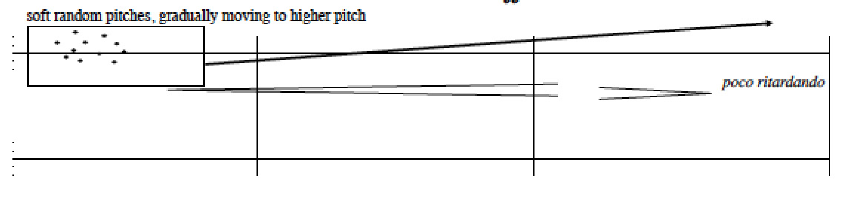
Figure 5. Alternative notation in the piano part, mm